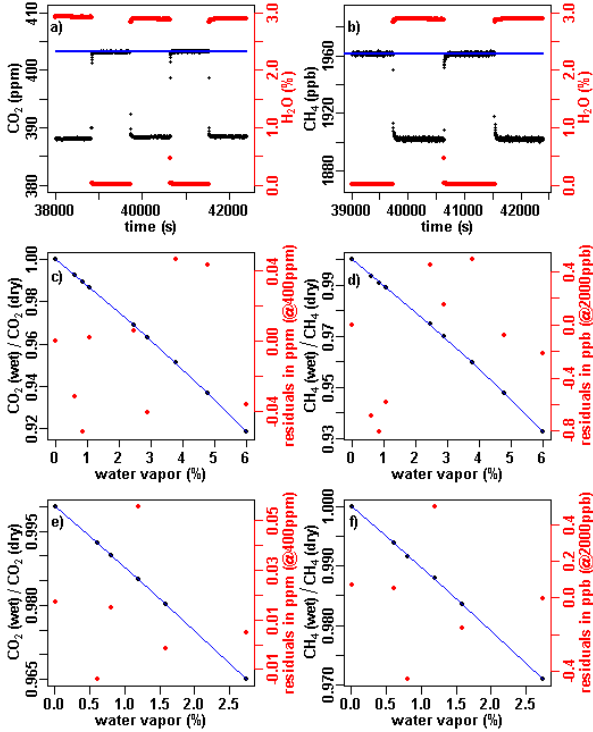
Fig. 2. (a–b) Examples of the responses of CO 2 and CH 4 while switching between wet and dry air (see H 2 O on the right axis), and linear drift corrections (blue lines). On the time axis, the values are the seconds that have lapsed since the beginning of the day when the experiment was carried out (c–d) Quadratic fits of CO 2wet /CO 2dry and CH 4wet /CH 4dry vs. H 2 O mixing ratios. (e–f) Results from sim- ilar experiments performed with CFADS 15, with the curve show- ing the fit from experiments using CFADS 37. The red dots in (a–d) are residuals of corresponding fits and are read on the axis to the right. Note that (a–d) are results from experiments performed with CFADS 37 and (e–f) with CFADS